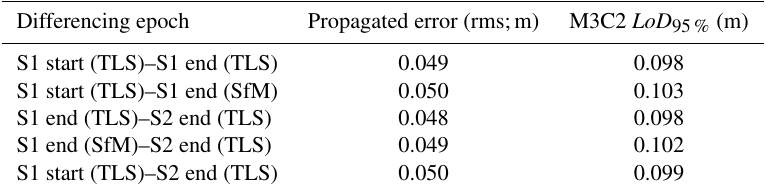
Table 2. Registration error propagation for specific differencing epochs. The propagated error for each differencing epoch is calculated using Eq. 3. The 95% level of detection or detection threshold is calculated in M3C2 as the product of the propagated error and a measure of local point cloud roughness (Lague et al., 2013). The results of 3-D differencing were filtered in CloudCompare so that only differences larger than the most conservative (largest) LoD 95% (i.e. 0.103m) were considered to represent significant change.